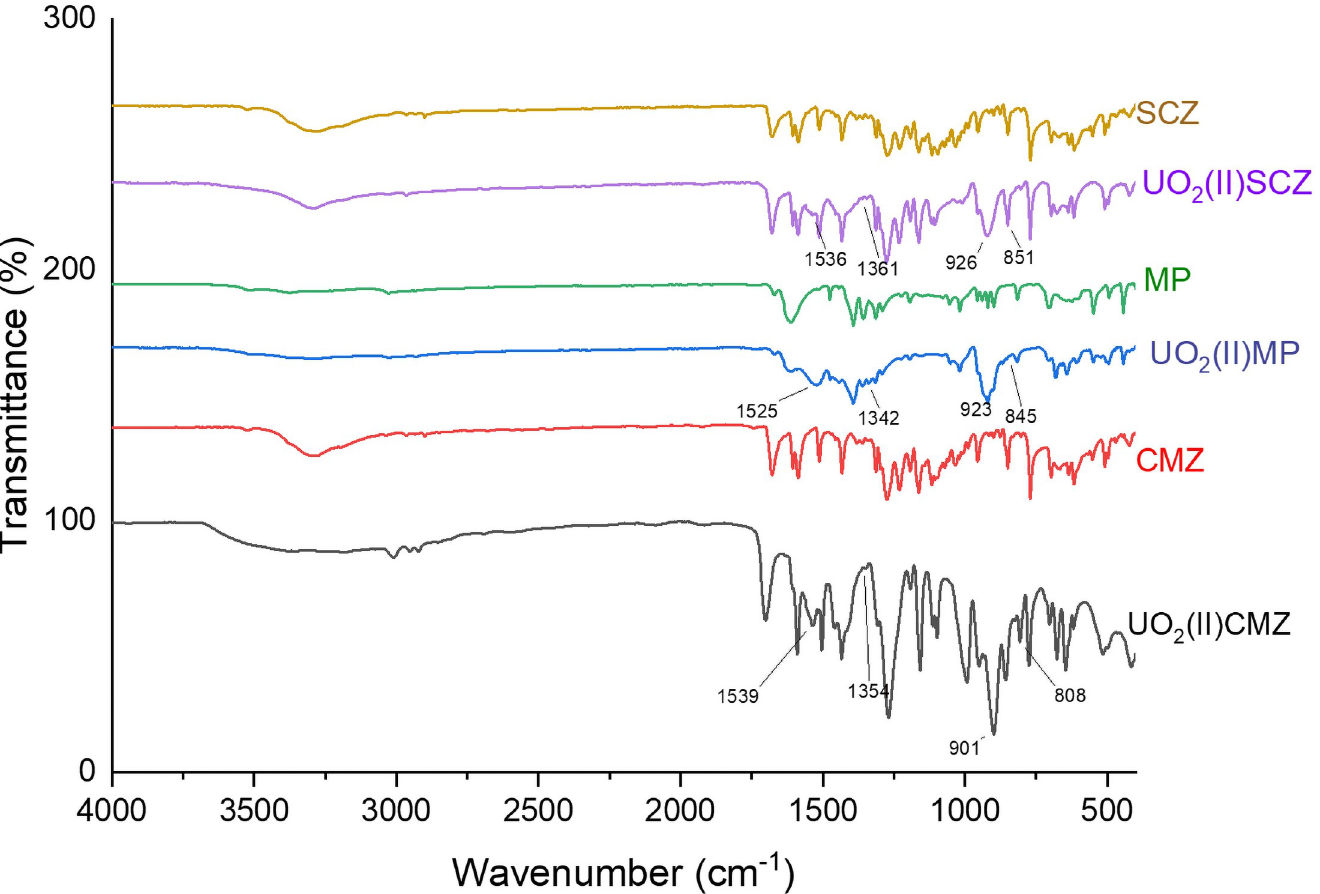
Fig 1. IR spectra of the free ligands (CMZ, MP and SCZ) compared to their (UO 22+ ) complexes.